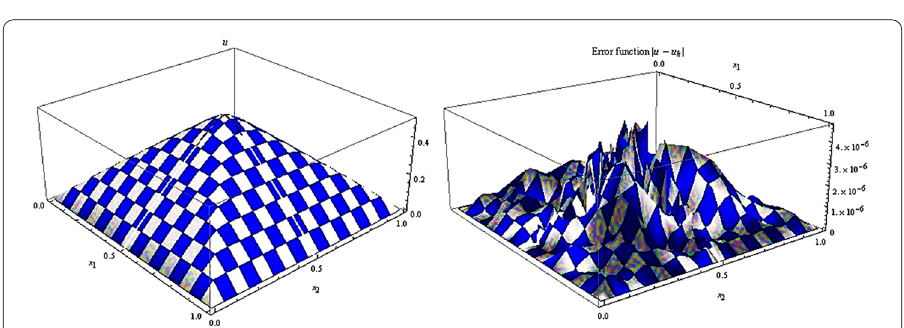
Figure 7 Graphs of the SMRPI solution and the error with h = 1/32 and p = 11 for Example 4